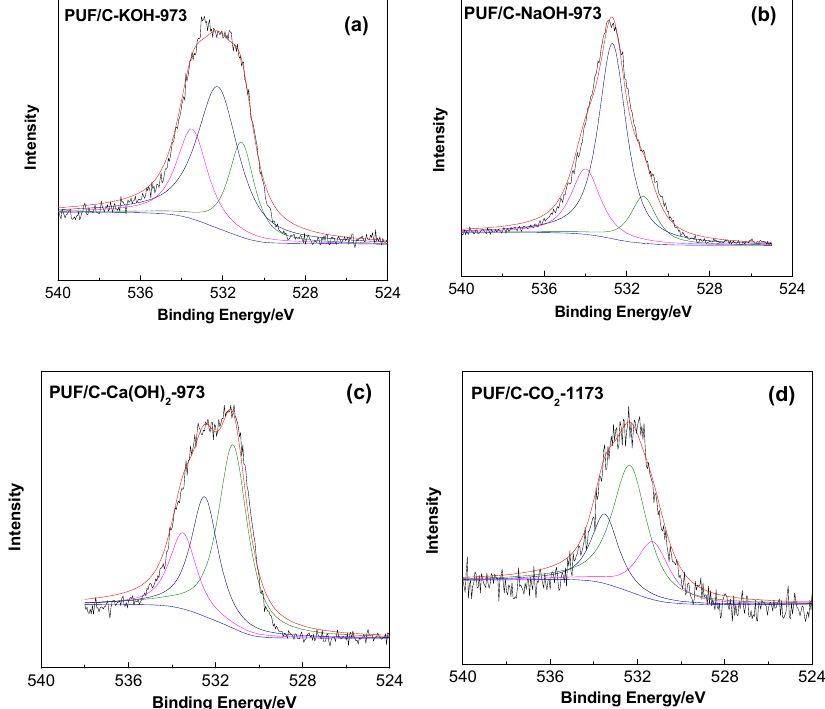
Figure 3. FT-IR spectra of the obtained samples prepared by physical and chemical activation. Processes 2019 , 7 , x FOR PEER REVIEW